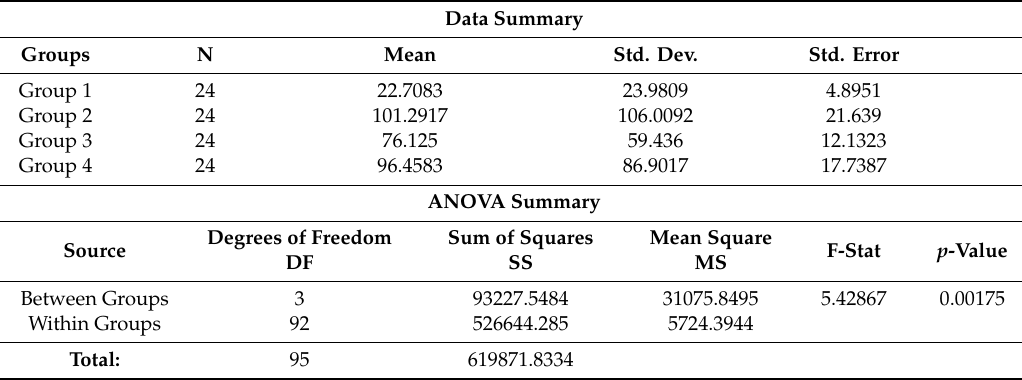
Table 6. Results of the ANOVA analysis for elongation at break.